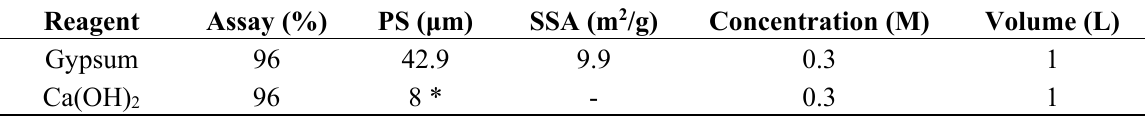
Table 1. Specifications, particle size (PS), and specific surface area (SSA) of the raw materials.